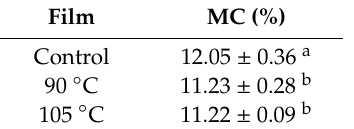
Table 1. Moisture content (MC) of control and thermally treated